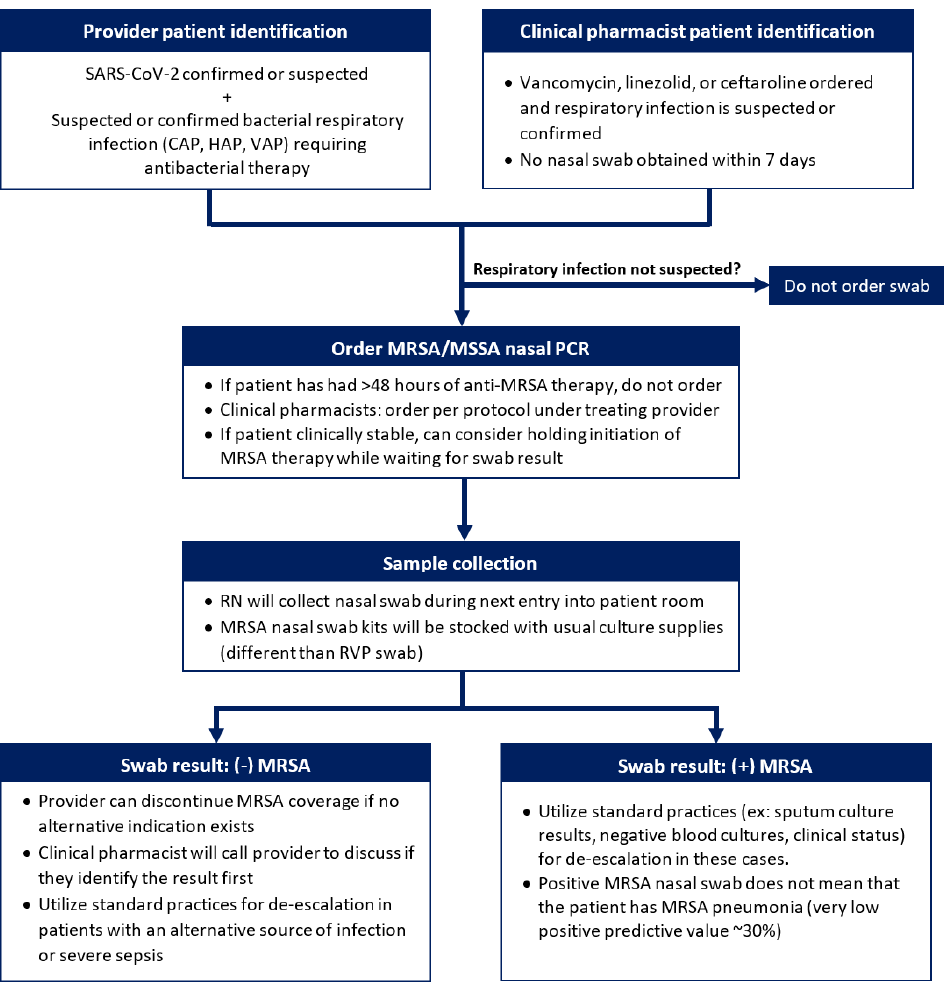
Figure 1. Workflow for ordering, obtaining, and interpreting the results of the MRSA PCR nasal swabs.